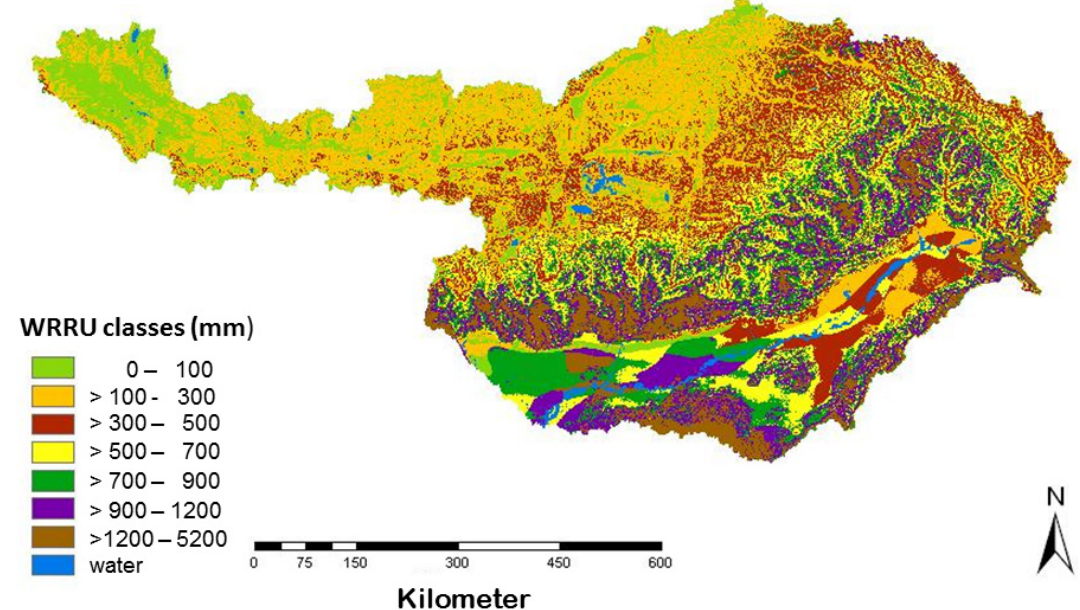
Figure 1. Water Resources Response Units (WRRU) distributed within the UBRB.